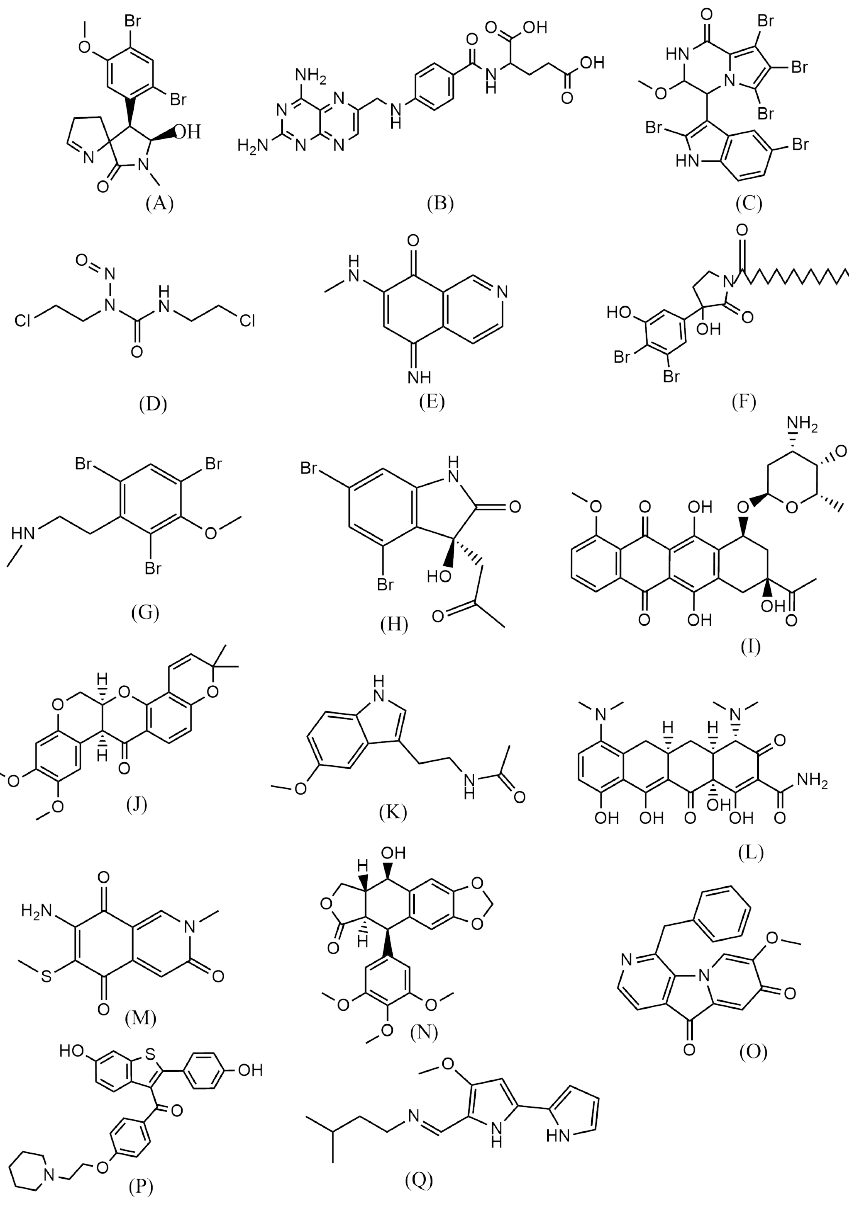
Figure 1: Molecular structure of anticancer drugs (A) Amathaspiramide E; (B) Aminopterin; (C) Aspidostomide E; (D) Carmustine; (E) caulibugulone E; (F) Convolutamide A; (G) Convolutamine F; (H) convolutamydine A; (I) Daunoru- bicin; (J) Deguelin; (K) Melatonin; (L) Minocycline; (M) Perfragilin A; (N) Podophyllotoxin; (O) Pterocellin; (P) Raloxifene; (Q) Tambjamine K.